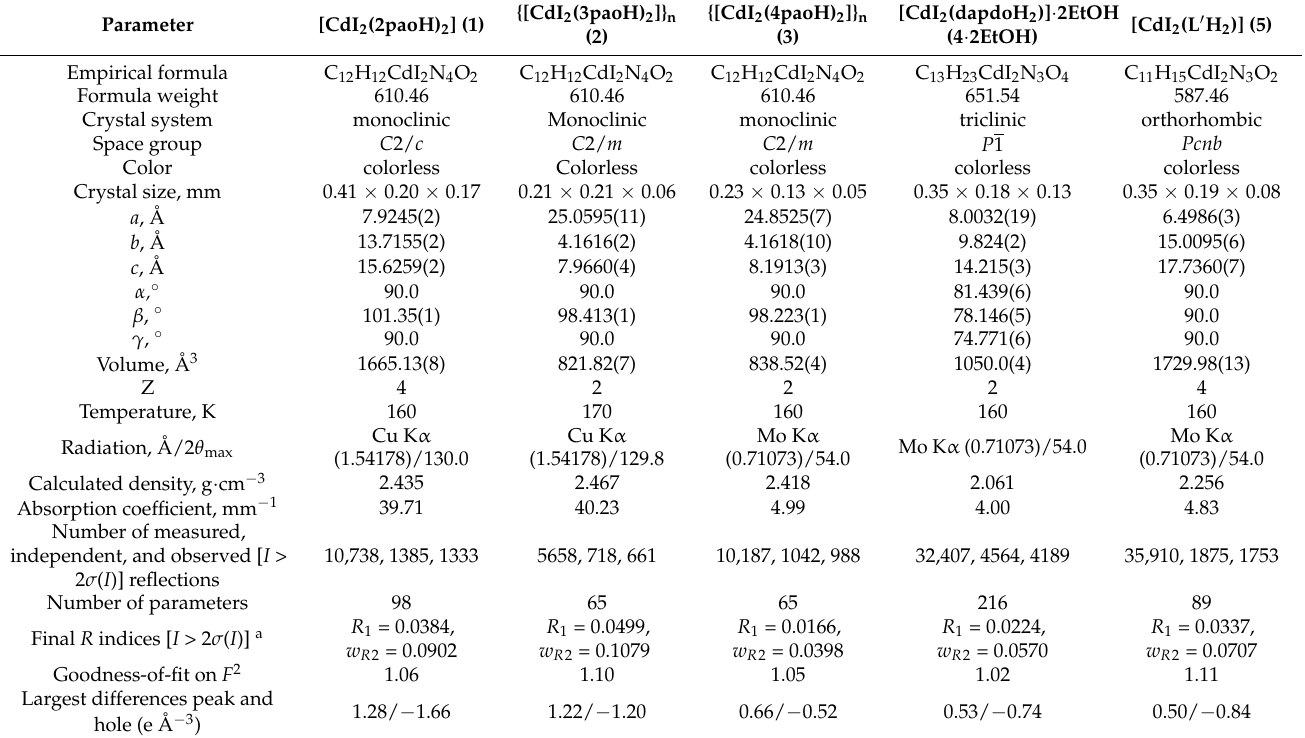
Table 1. Crystallographic data and refinement parameters for the structures of 1 , 2 , 3 , 4 · 2EtOH and 5